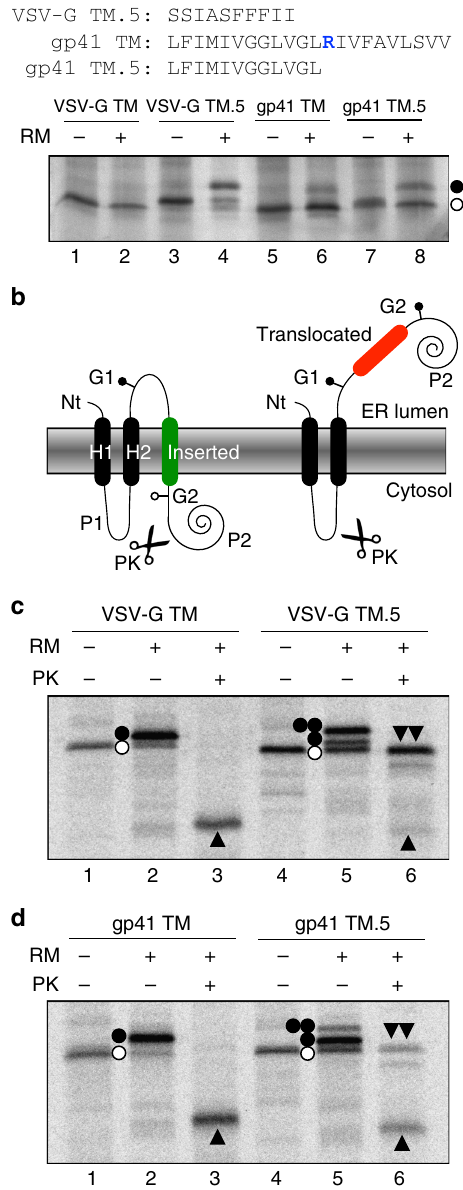
Fig. 5 Folding depends on hydrophobic length and correlates with insertion. a In vitro translation in the absence ( − ) and presence ( + ) of dog pancreas rough microsomes (RM) of truncated mRNAs of the same length (distance P-NST 67) harboring VSV-G full length (lanes 1 and 2) or half (VSV-G TM.5, lanes 3 and 4) TM segment, or gp41 full length (lanes 5 and 6) or half (gp41 TM.5, lanes 7 and 8) TM segment. Glycosylated and non-glycosylated molecules are indicated by black and white dots, respectively. Amino acid sequences included are shown on top. b Schematic of the engineered leader peptidase (Lep) model protein. Lep, consisting of 2 TM segments (H1 and H2) and a large luminal domain (P2), inserts into RMs in an N lum -C lum orientation. In vitro protein translation in the presence ( + ) or absence ( – ) of rough microsomes (RM) and proteinase K (PK) of VSV-G ( c ) or gp41 ( d ) derived sequences. Non-glycosylated protein bands are indicated by a white dot; single and double glycosylated protein bands are indicated by one or two black dots, respectively. An upwards black triangle indicates small protected singly glycosylated H2/inserted fragment. A double downward black triangle indicated large doubly glycosylated H2/G1/trasnlocated/G2/ P2 fragment. Source data are provided as a Source Data fi